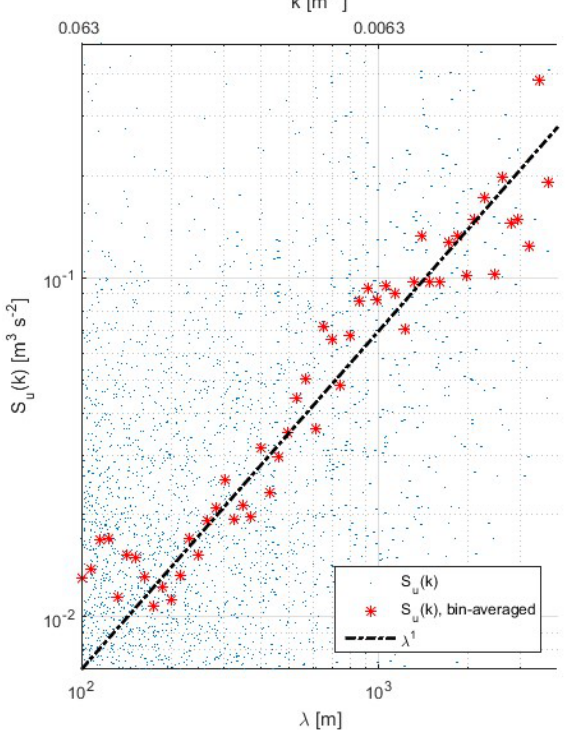
Figure 11. Velocity power spectrum obtained by ADCP at 10 m depth. Blue dots are individual realizations obtained over two-hour segments throughout the length of the experiment. Red asterisks are bin averages of all spectra, each corresponding to an average of all realizations within a segment of the length scale λ . Dash-dotted line is an approximate fit to bin-averaged values, given by Equation (4).